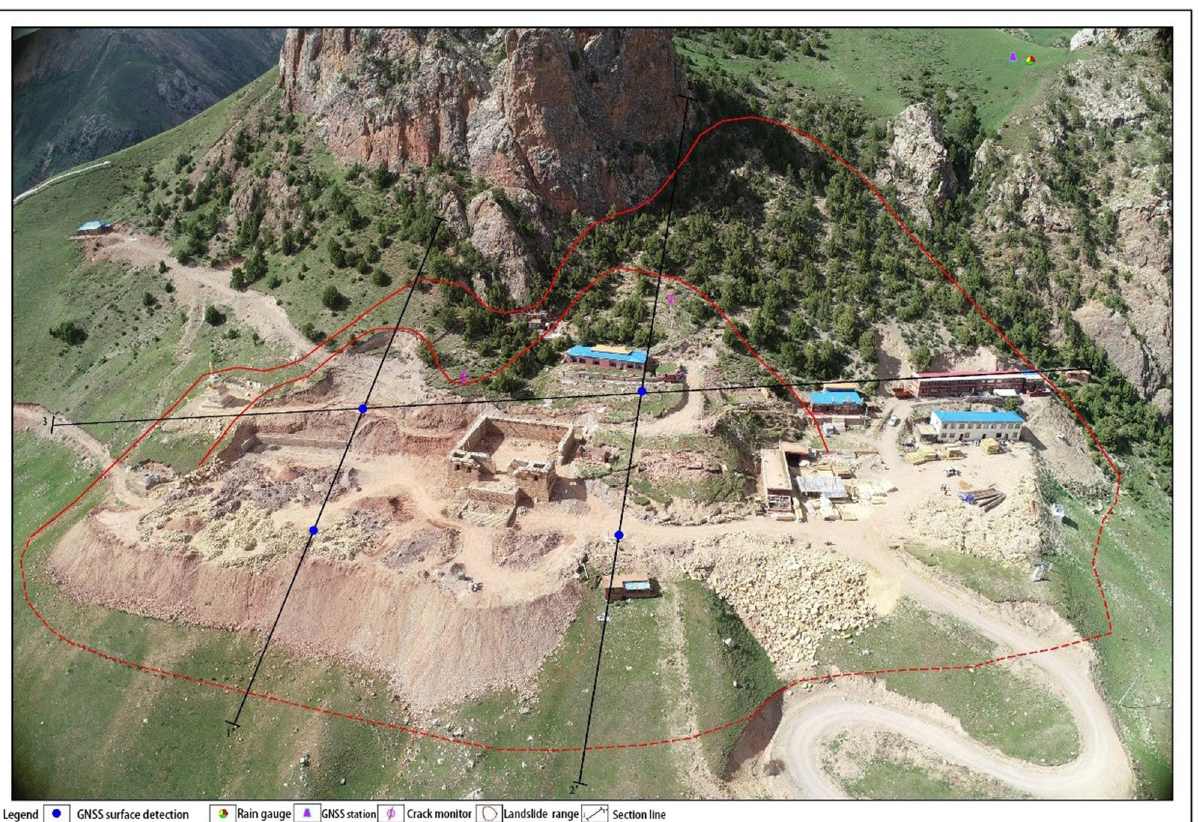
Figure 6. Landslip monitoring